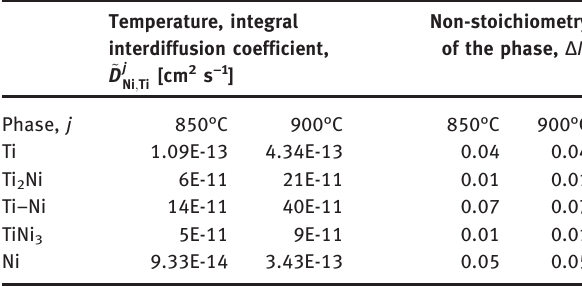
Table 1: The kinetic data used to simulate reactions in Ti – Ni system at 850°C and 900°C.